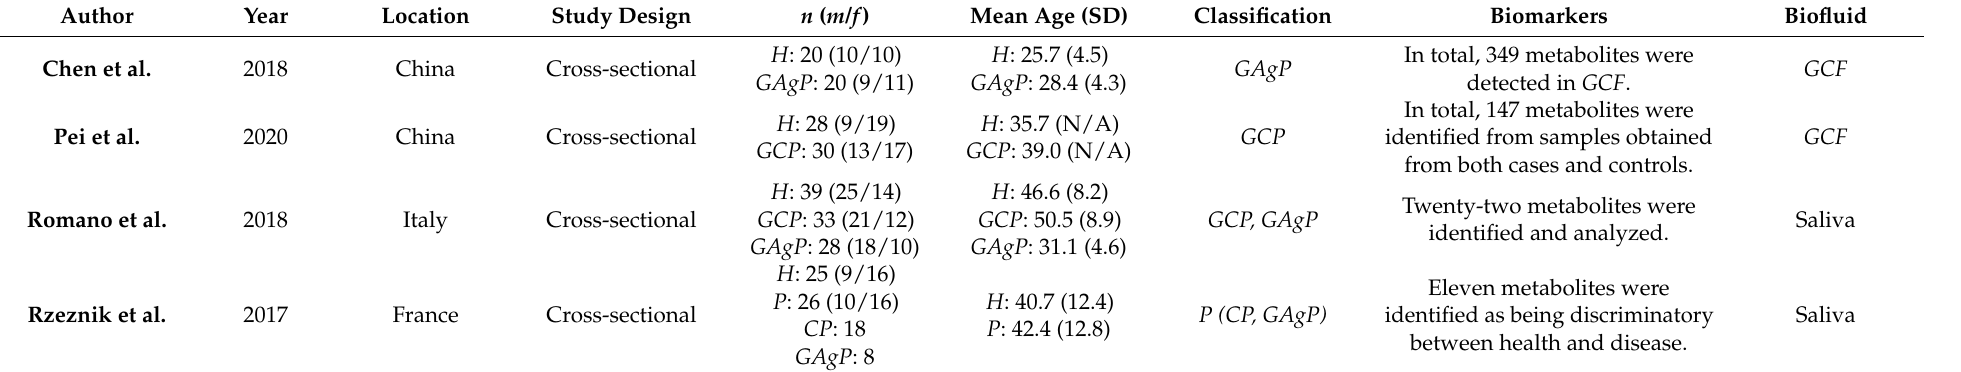
Table 4. Base-line characteristics of studies analyzing metabolite-based biomarkers in oral biofluids.